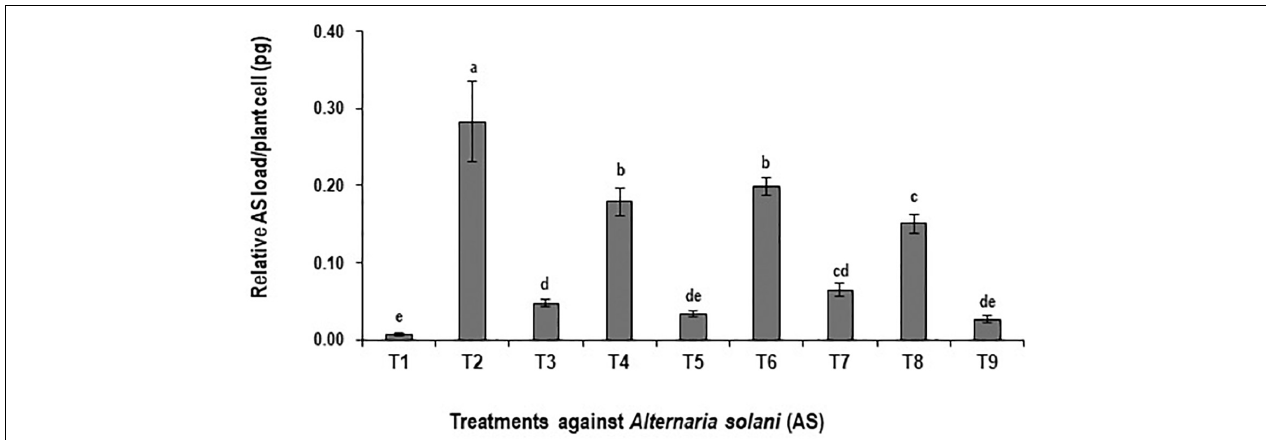
FIGURE 1 | Effect of Bacillus subtilis (BS-01) on the relative fungal load of Alternaria solani (AS) in tomato foliage using qPCR after 10 days of pathogen inoculation. Values with different letters show a significant difference ( p ≤ 0.05) in the mean value of replicates as determined by the LSD test. Error bars indicate the standard errors of the mean of replicates. − ve control, without inoculation of AS and nutrient application; +ve control, with inoculation of AS only (foliar application). T 1 , − ve control; T 2 , +ve control; T 3 , BS-01 + AS; T 4 :, Zn (2X) + AS; T 5 , BS-01 + Zn (2X) + AS; T 6 , NPK + AS; T 7 , BS-01 + NPK + AS; T 8 , Zn (2X) + NPK; and T 9 , BS-01 + Zn (2X) + NPK +